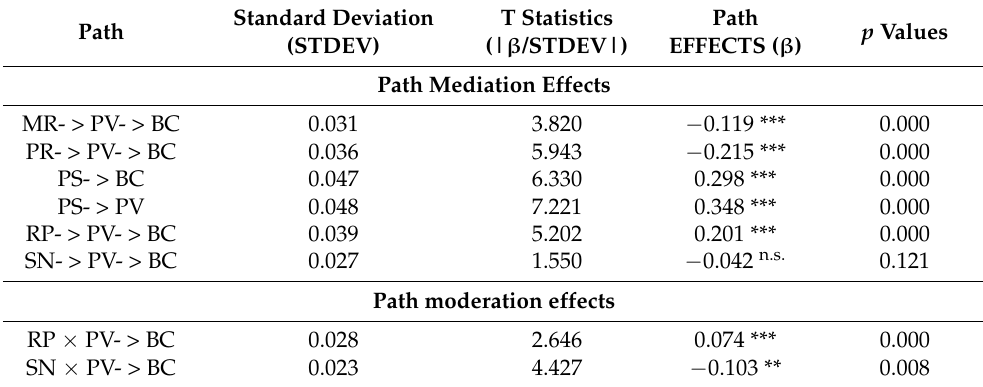
Table 9. Path mediation and moderation effects estimation of research